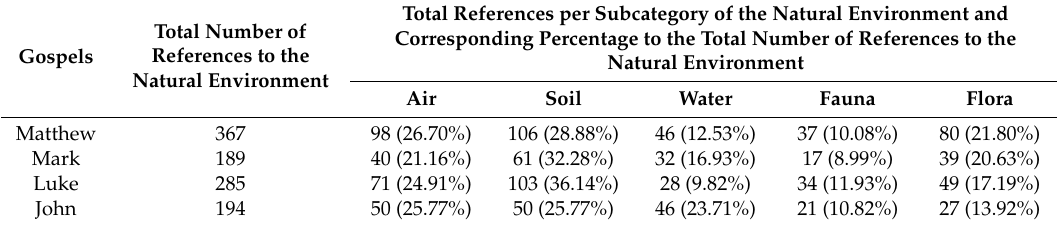
Table 5. Number of references to the natural